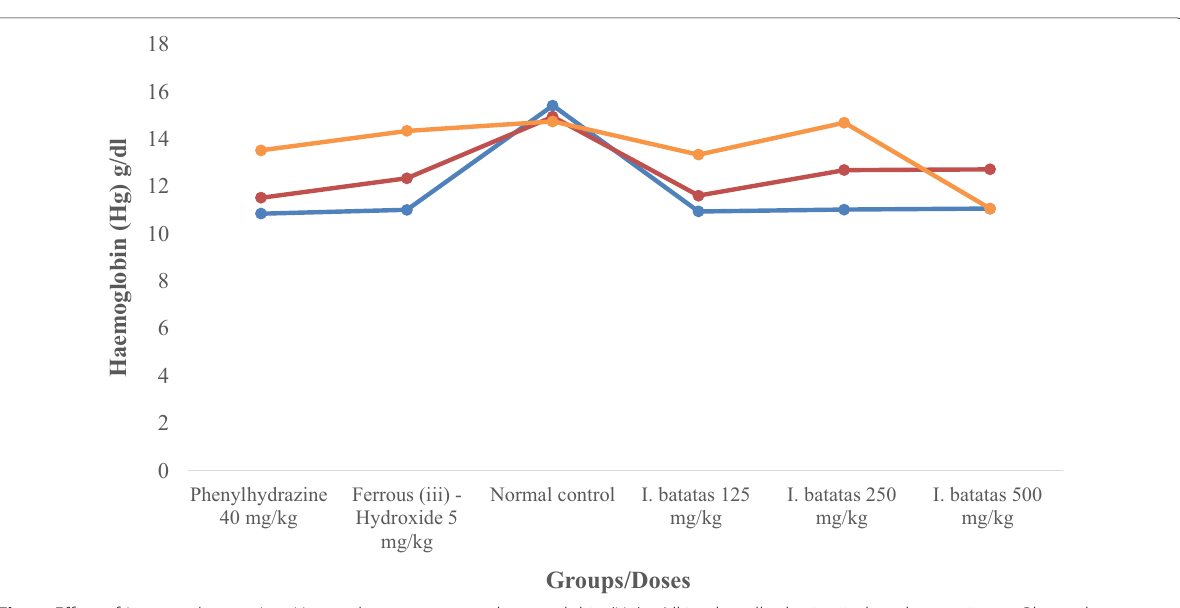
Fig. 4 Effect of Ipomoea batatas L . n-Hexane leaves extract on haemoglobin (Hg) g/dl in phenylhydrazine-induced anaemic rats. Blue—day 1, red—day 7, orange—day 14